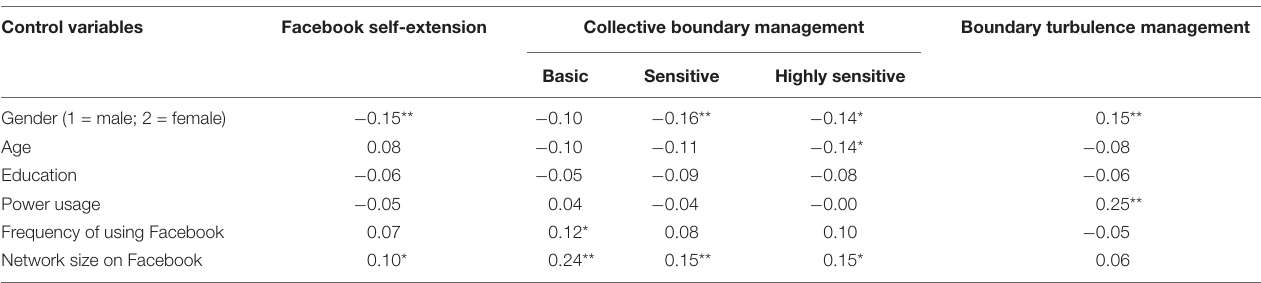
TABLE 2 | Effects of control variables on mediator and dependent